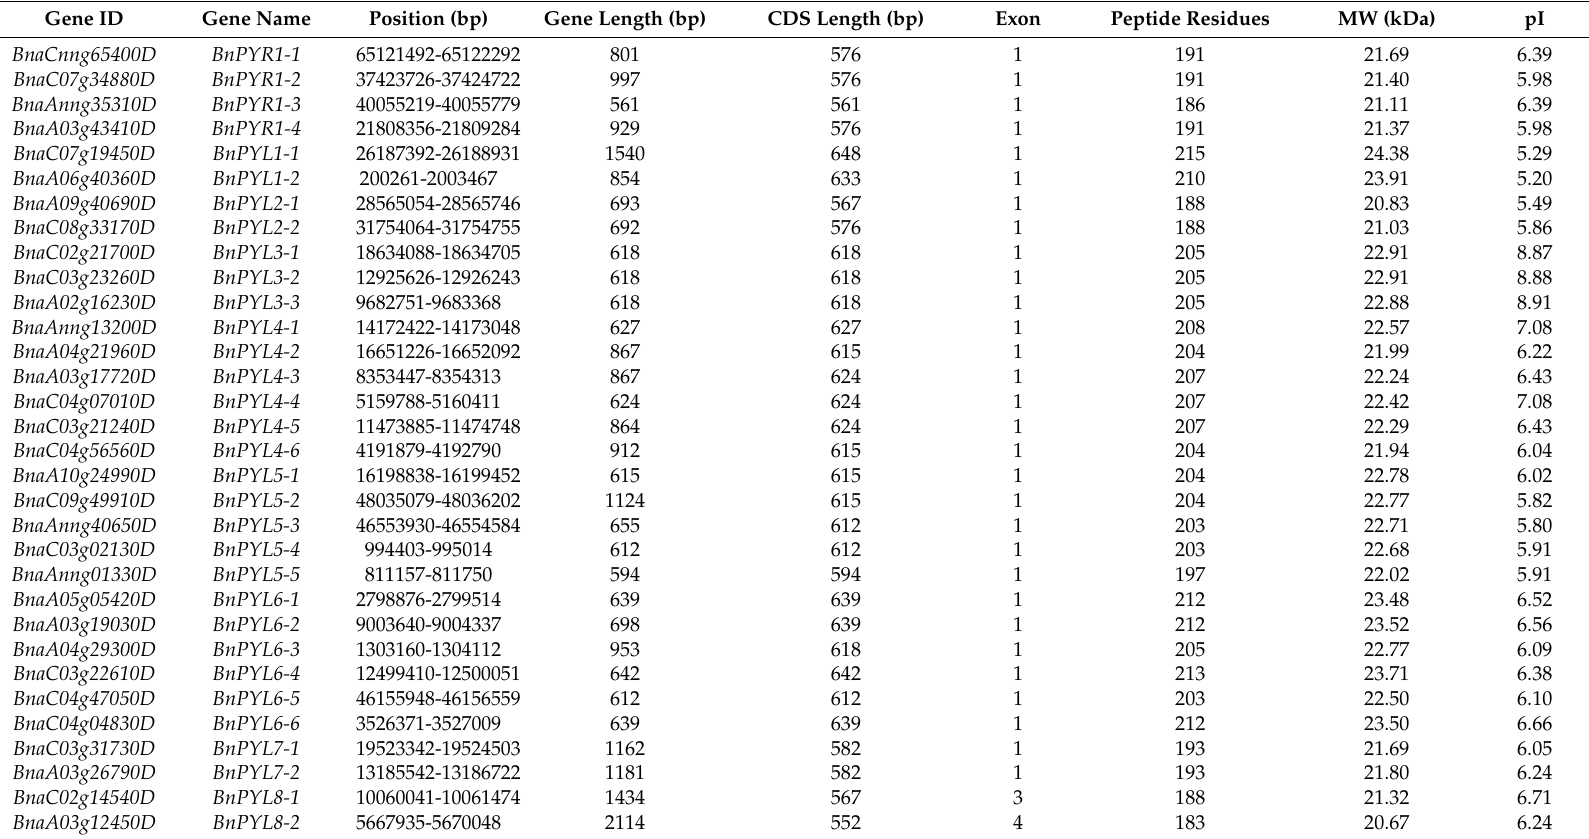
Table 1. PYL gene family information in Brassica napus